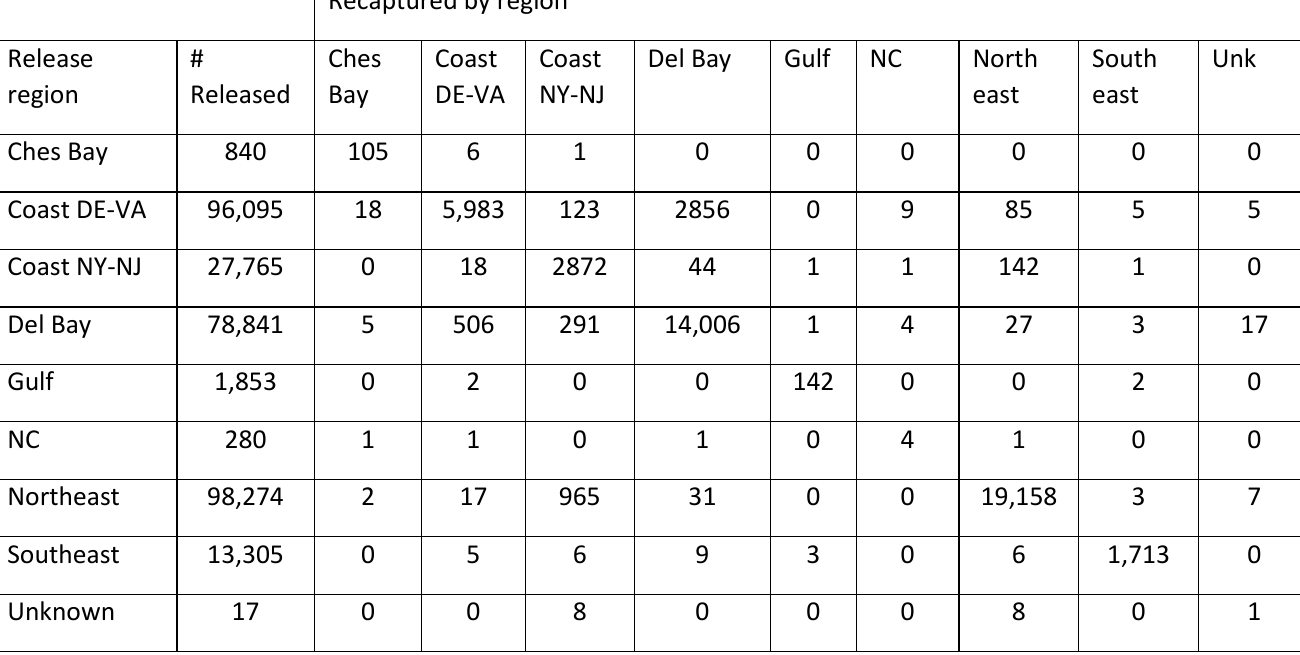
Table 3. Numbers of tags released and recaptured by